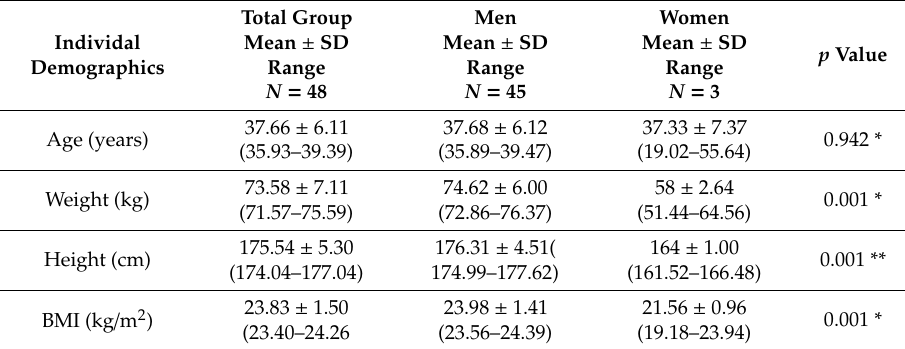
Table 1. Socio-demographic characteristics of the sample